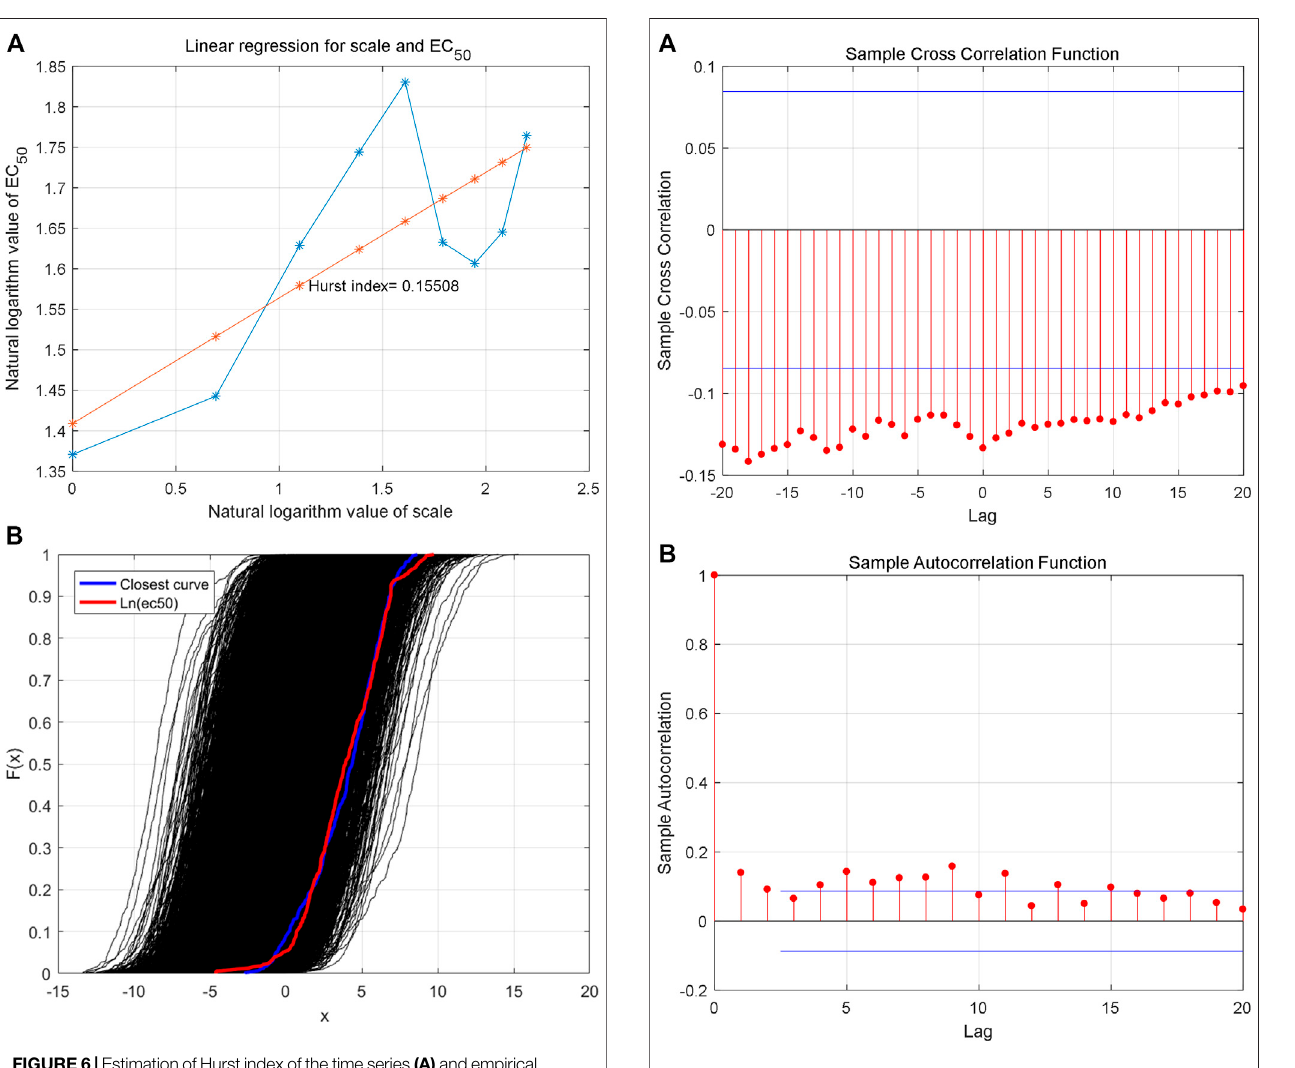
FIGURE6| EstimationofHurstindexofthetimeseries (A) andempirical probability distribution of FBM with the same Hurst index (B) . FIGURE 7 | Correlation analysis of the second group time series. (A) Cross-correlation with the sorting natural logarithm of coding AAS. (B) Autocorrelation of natural logarithm of AHTPA-EC 50